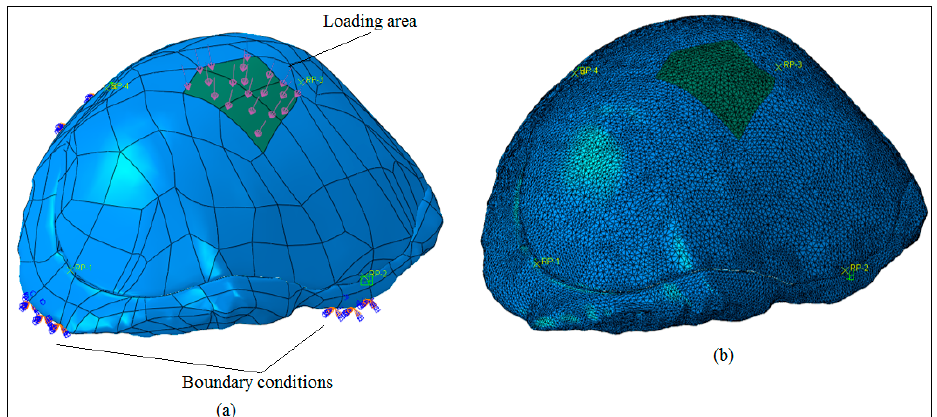
Figure 7. ( a ) Loading area and boundary conditions; ( b ) Mesh generation.